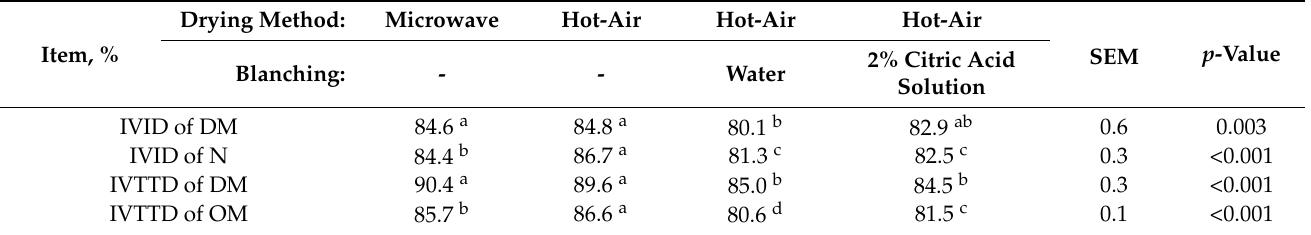
Table 2. In vitro ileal disappearance (IVID) of dry matter (DM) and nitrogen (N) and in vitro total tract disappearance (IVTTD) of DM and organic matter (OM) in four black soldier fly larva meals with various drying and blanching methods for pigs 1